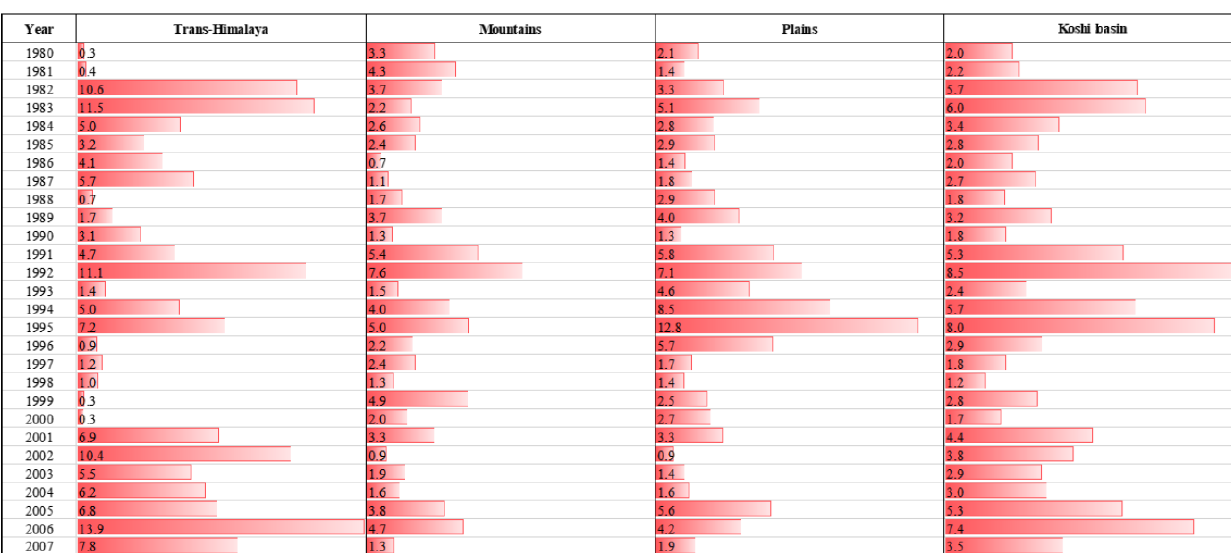
Table 4. Duration of drought events for trans-Himalaya, mountains, and plains and for the whole Koshi basin. The red bars correspond to values in the rows that show the number of weeks when SMDI < − 3 .